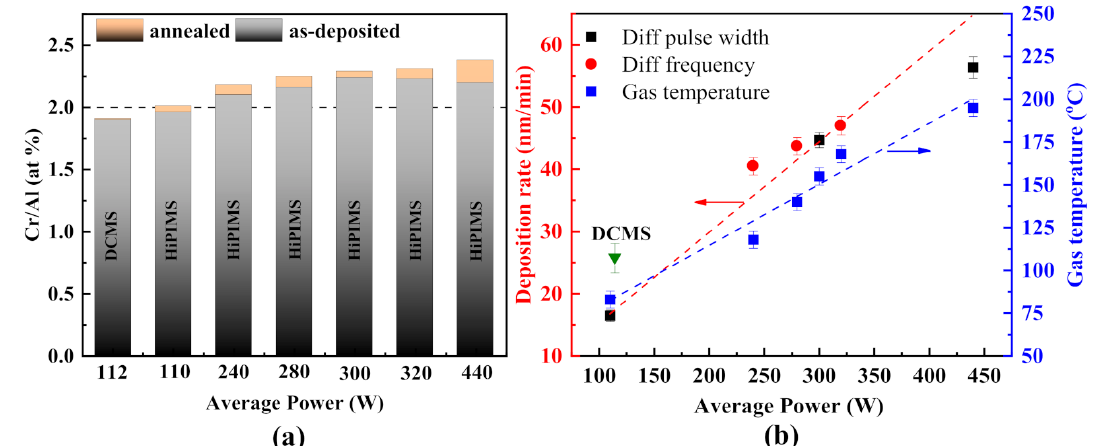
Figure 7. ( a ) Chromium to aluminum atomic ratio (Cr/Al) of the coatings deposited by DCMS and HiPIMS and ( b ) deposition rate and gas temperature around the substrate at different average power in HiPIMS ( (cid:72) is the deposition rate for Cr 2 AlC coating by DCMS for